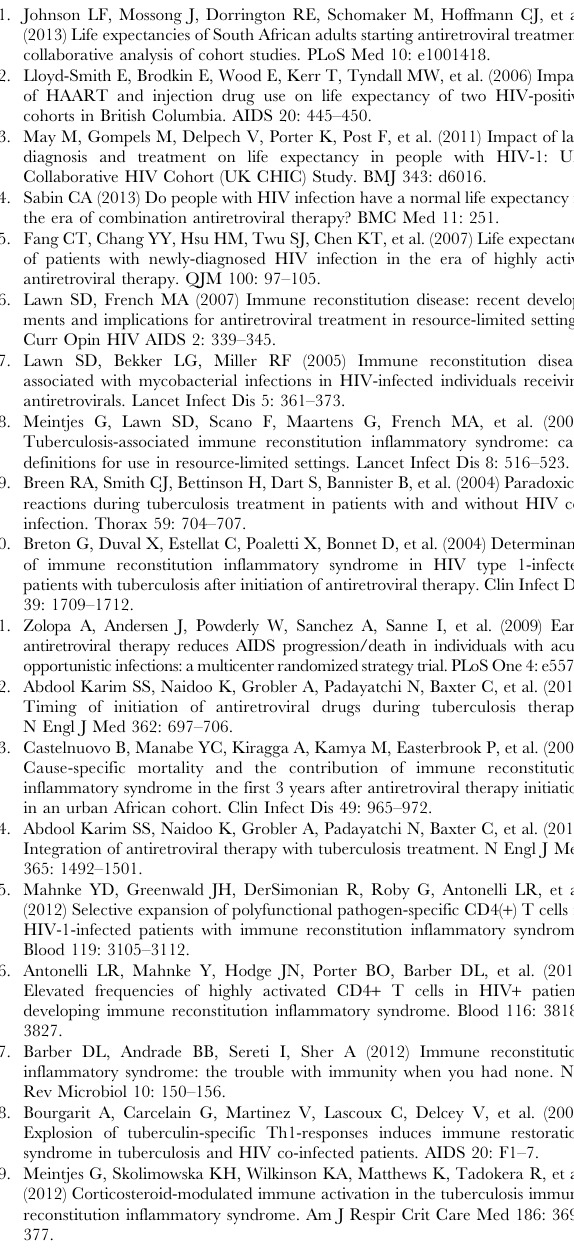
Table S1 Distribution of plasma biomarkers and cell counts in the Indian Cohort. Table S2 Distribution of plasma biomarkers and cell counts in the South African Cohort. Table S3 Baseline characteristics of the South African